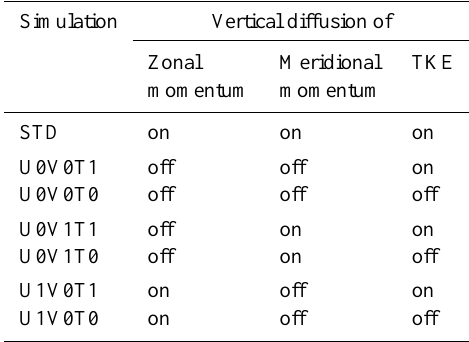
Table 1. Summary of simulations with different treatment of verti- cal diffusion of momentum. All simulations are performed for per- petual off-equatorial as well as seasonally varying insolation. The last column indicates whether full or suppressed eddy viscosities are used for the calculation of turbulent kinetic energy (TKE). See text for